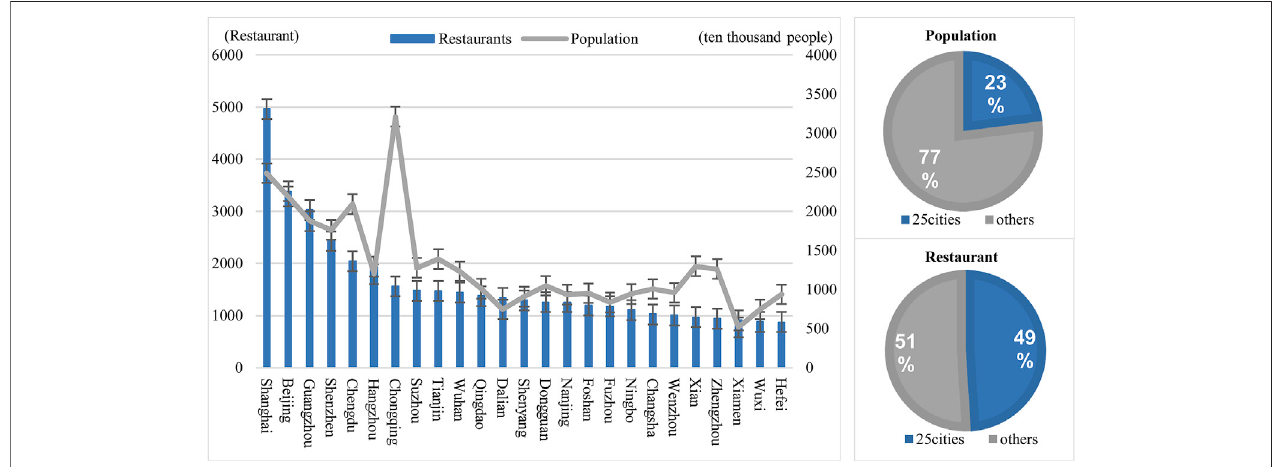
FIGURE 4 | Cities with top 25